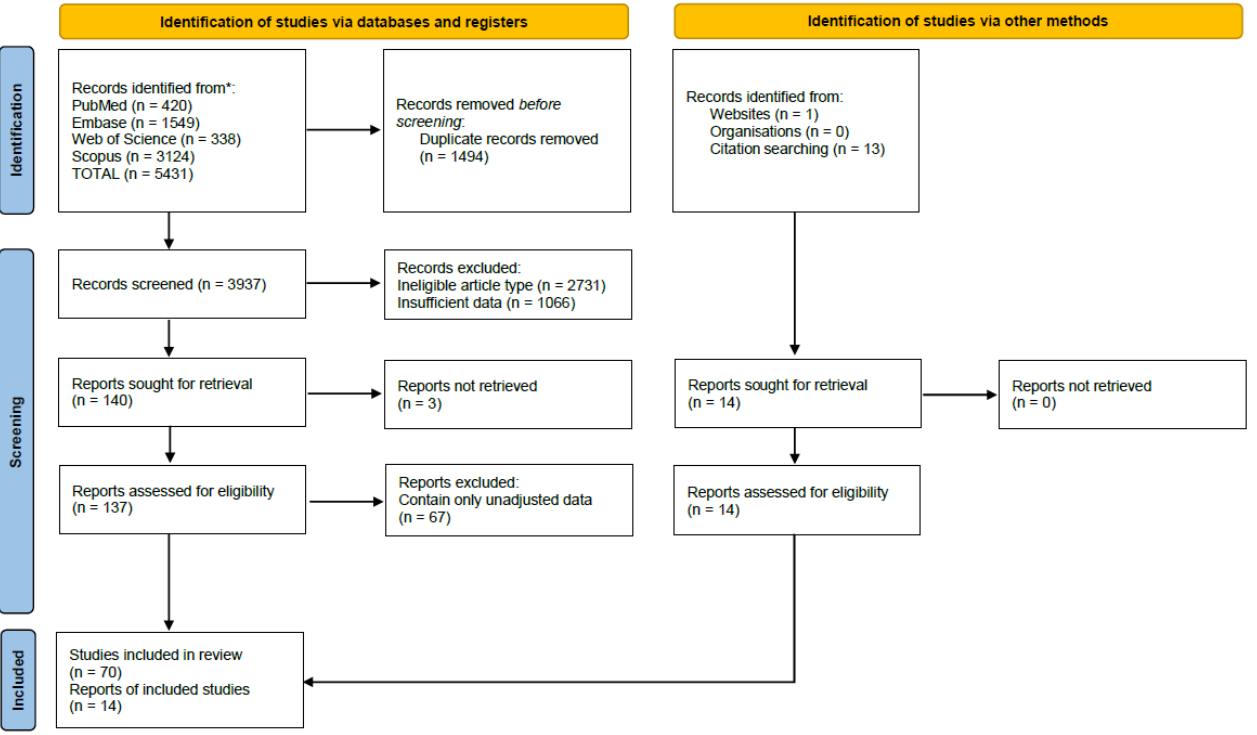
Figure 1. PRISMA flowchart for study selection.